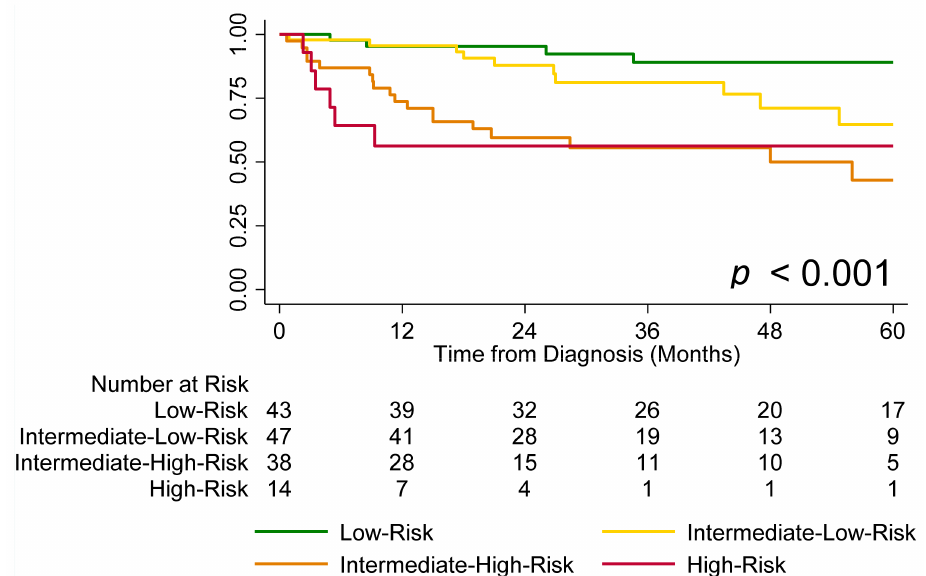
Figure 2. Transplant-free survival by risk group (low vs. intermediate-low vs. intermediate-high vs. high) using tricuspid annular plane systolic excursion (TAPSE) to further stratify intermediate- risk patients. Note: Four intermediate-risk patients had missing TAPSE and were not included in the analysis.